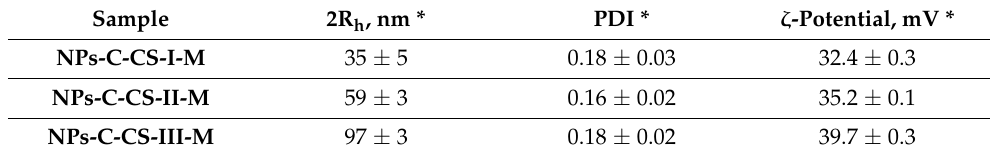
Table 3. Characteristics of the self-assembled nanoparticles (Scheme 1, system 2).